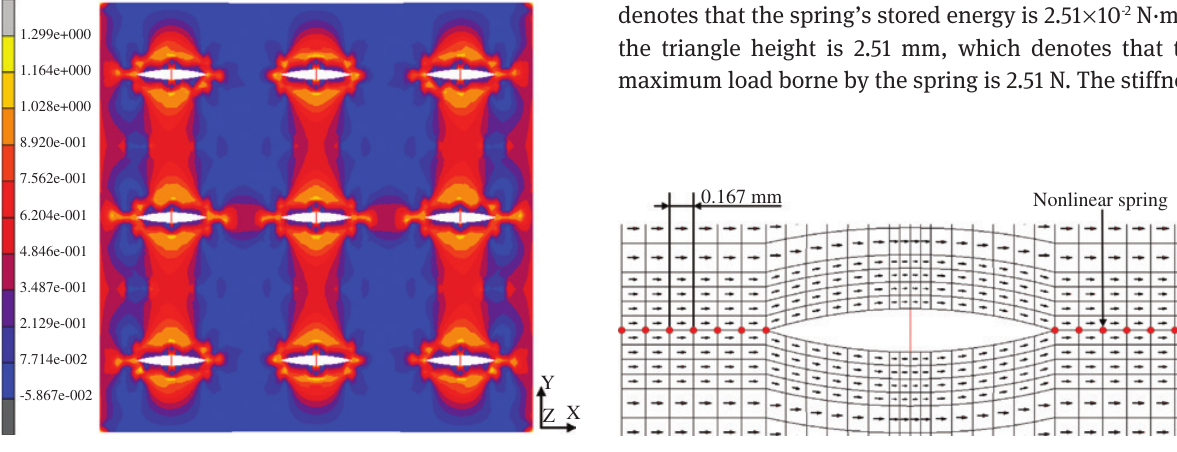
Figure 11: Distribution of the second failure factor in [0]